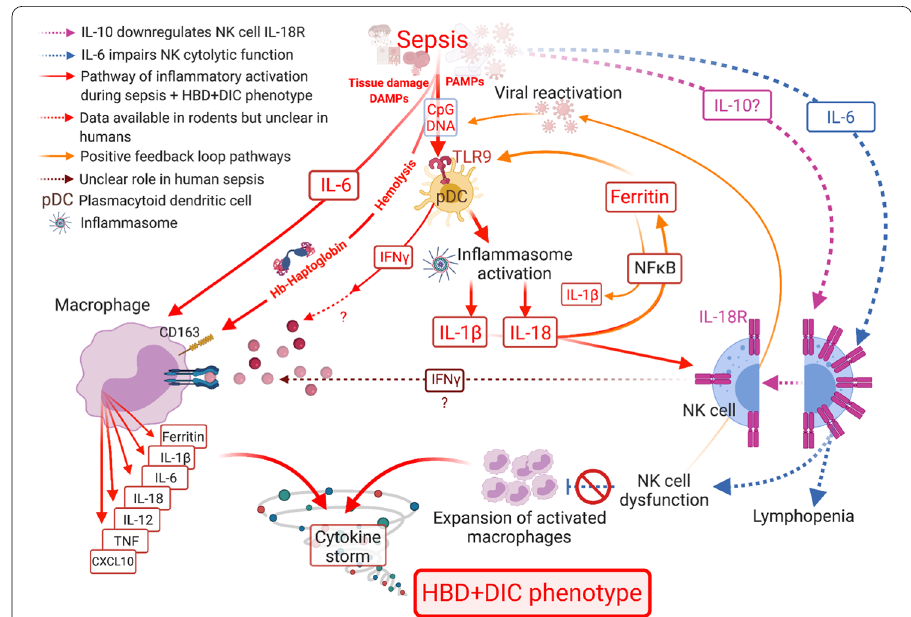
Fig. 3 Cell and inflammatory mediator interplay potentially contributes to the development of HBD DIC in + septic patients. Sepsis-induced NK cell deficiency triggers latent viral reactivation, with viral DNA initiating a TLR9-MyD88-mediated signaling cascade [6, 52]. Subsequent inflammasome activation leads to the secretion of IL-18 and IL-1β [6, 56]. In addition to mediating liver injury [59], IL-1β increases transcription and translation of ferritin [60], and production of IL-6 [5]. The release of damage associated molecular patterns (DAMPs), such as mitochondrial DNA or hemoglobin after tissue injury or hemolysis, triggers macrophage activation independent of IFN-γ. Release of free hemoglobin increases hemoglobin-haptoglobin complexes, activating macrophages to produce extracellular ferritin through the CD163 receptor [6, 56]. Ferritin promotes expression of IL-1β and TLR9 [57, 58], resulting in a positive feedback loop with amplification of inflammatory signals [56]. IL-18, in combination with a secondary signal, such as IL-12 or TLR ligands, activates NK cells to produce IFN-γ [53, 64]. We hypothesize, though, that in the context of sepsis with HBD DIC, NK cells are + limited in their responsiveness to IL-18 due to IL-10-mediated downregulation of the IL-18R [55]. As a result, circulating IFN-γ levels are reduced. However, IL-6 enhances signaling through TLRs, increasing the secretion of proinflammatory mediators, including CXCL10 [5]. Persistent NK cell cytolytic dysfunction, stemming from decreased cell number [52] and high levels of IL-6 [54], translates into an impaired ability to induce apoptosis of activated macrophages [6]. In addition, inflammatory mediators produced by macrophages reinforce macrophage (ferritin, IL-6, IL-1β, IL-12, TNF), pDC (ferritin), and lymphocyte (IL-18, IL-12, CXCL10) activation. Thus, the inflammatory cycle continues unabated (cytokine storm), resulting in organ dysfunction and death in the absence of appropriate therapies. The role of pDC- and NK cell-derived IFN-γ in macrophage activation during sepsis remains unclear. In our study, IFN-γ levels were low, although two of its downstream mediators, CXCL10 and IL-18BP, were elevated in patients with sepsis and HBD +